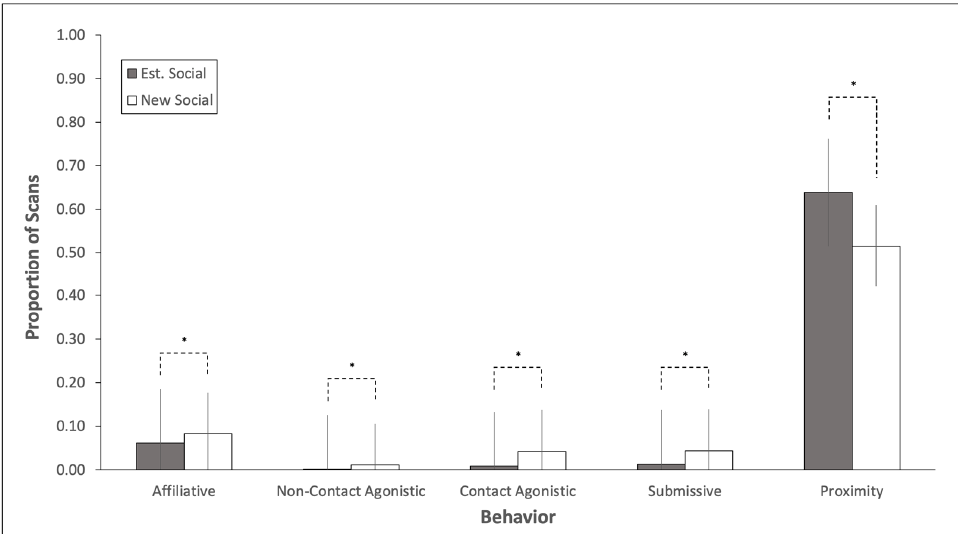
Figure 3. Proportion of scans when a focal animal engaged in social behaviors in different social groups. Bulls housed in new social groups engaged in significantly more affiliative behavior, more agonism (both non-contact and contact), and more submissive behaviors than when they were in established social groups. Despite the increase in some social behaviors, bulls spent significantly less time in proximity to a conspecific in new social groups compared to established social groups. Est. Social = social groups that were housed together prior to this study, both at Denver Zoo and at Individual 4 and 5′s previous institution. New Social = social groups introduced during this study, beginning in February 2019. * indicates p < 0.05.